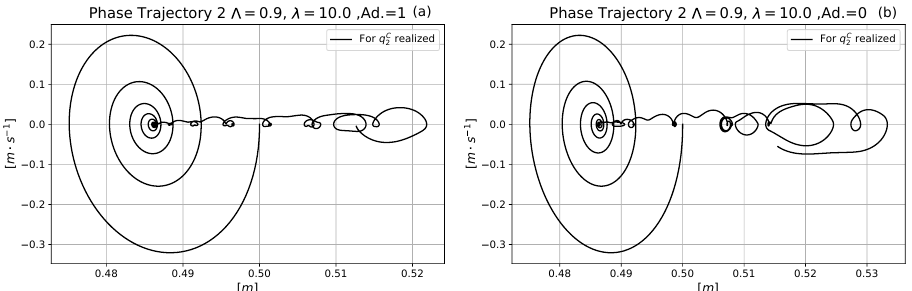
Figure 21. The phase trajectory tracking. ( a ): Adaptive. ( b ): Non-adaptive.